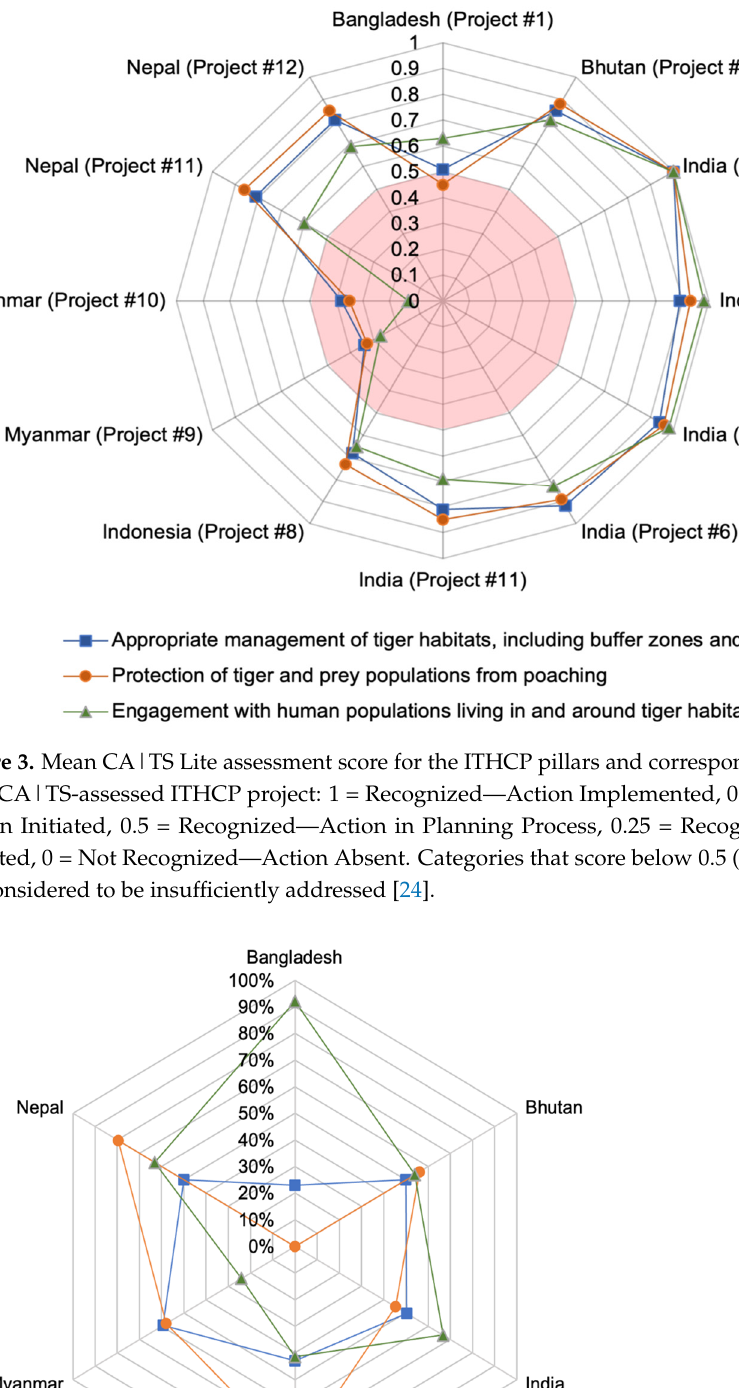
Figure 5. Average per country of mean CA|TS Lite assessment score for the ITHCP pillars: 1 = Rec- ognized—Action Implemented, 0.75 = Recognized—Action Initiated, 0.5 = Recognized—Action in Planning Process, 0.25 = Recognized—No Action Initiated, 0 = Not Recognized—Action Absent. Categories that score below 0.5 (shown in light red) are considered to be insufficiently addressed [24].